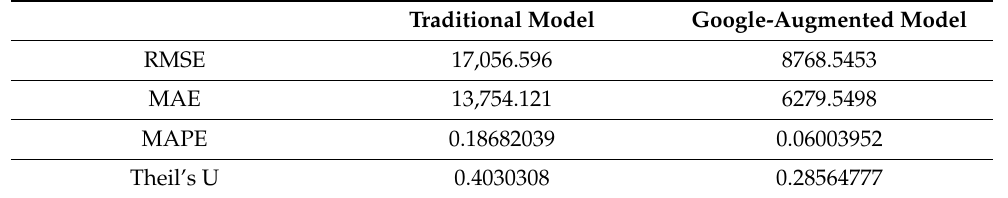
Table 2. Forecast accuracy comparison.